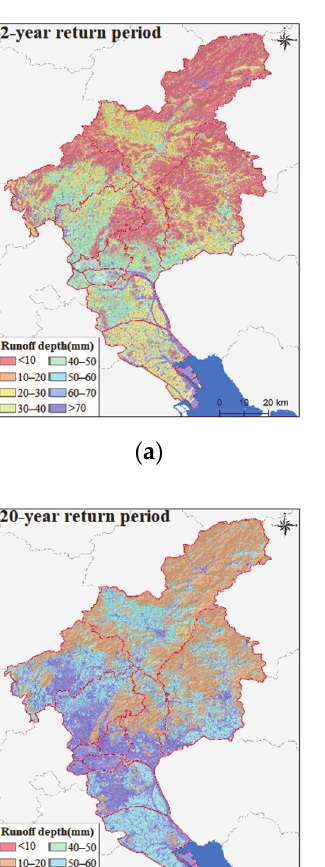
9 of 18 Table 3. Urban waterlogging risk assessment indicators and weights. Factors